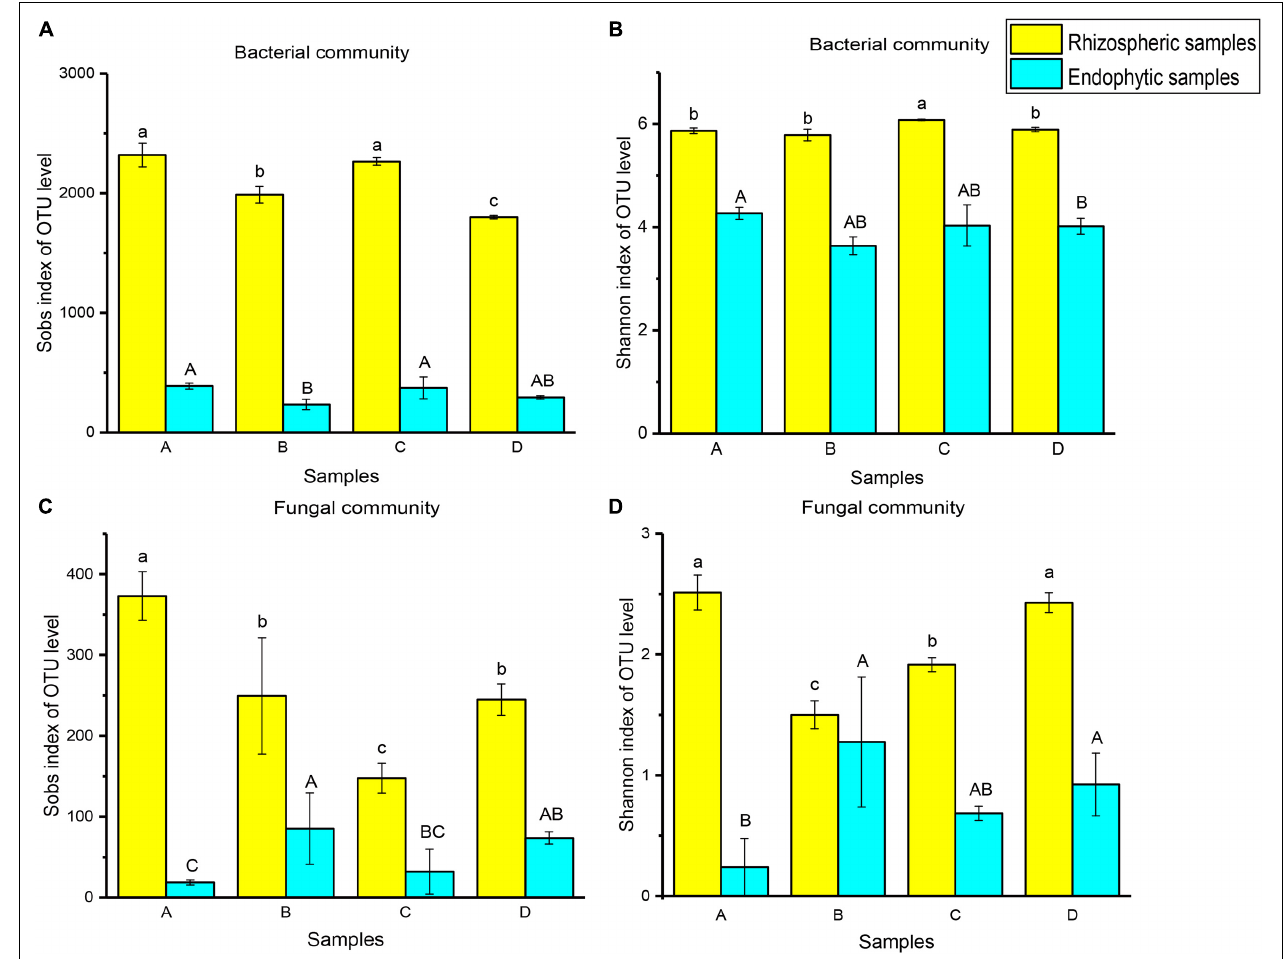
FIGURE 2 | Ejinur Salt Lake different rhizosphere soil and root endophytic samples of microbial α -diversity. Different uppercase (Endophytic samples) and lowercase (Rhizospheric samples) letters indicate significant differences among plant species ( p < 0.05). The abscissa letters indicate the plant species [ S. europaea (A) , S. salsa (B) , P. communis (C) , and A. splendens (D)